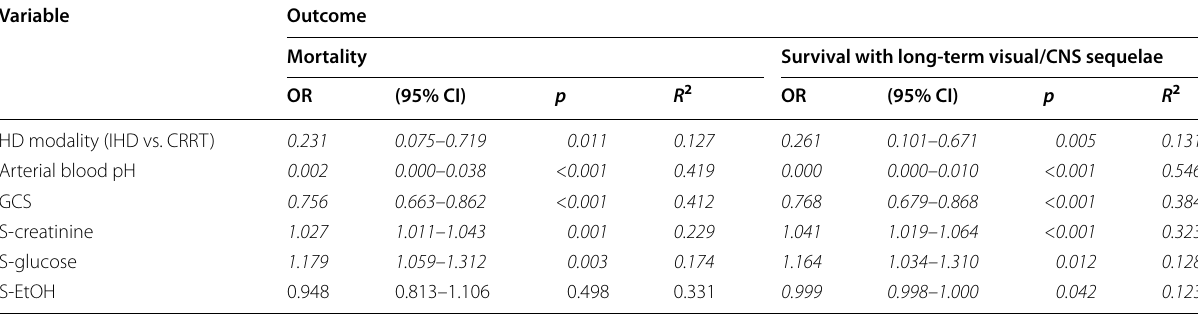
The alpha level used in the univariate analysis is α